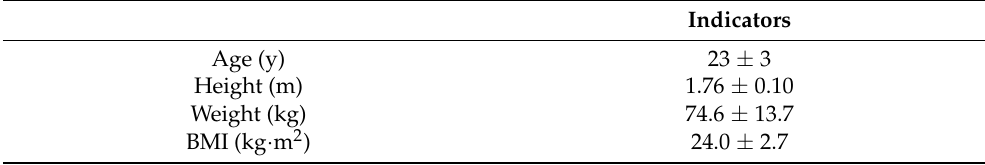
Table 1. Participant characteristics ( n = 16).